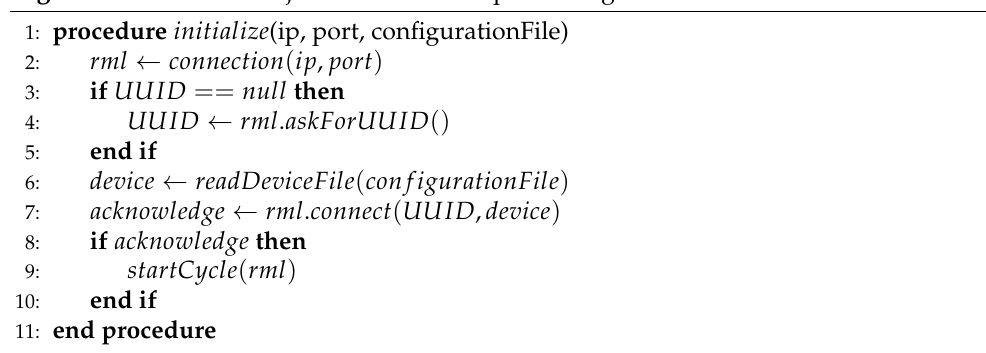
Algorithm 1. The IoT Object’s initialization process algorithm.